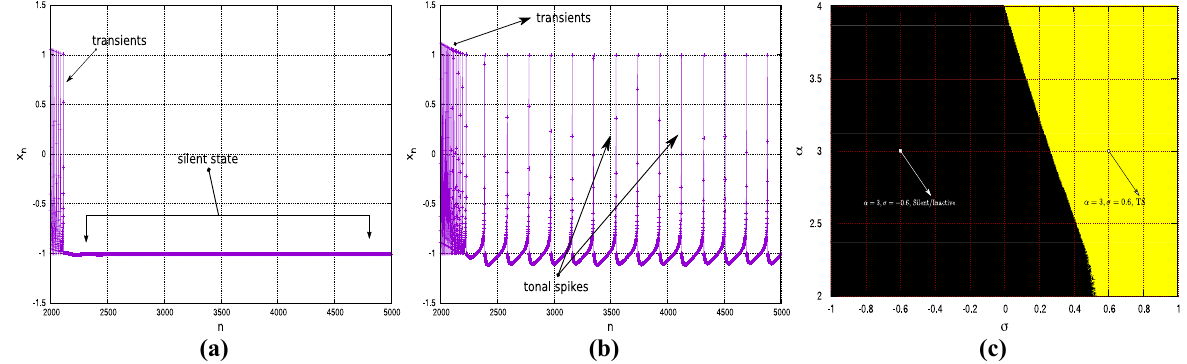
Figure 10. Time-series plots of an isolated neuron exhibiting different dynamical states at long time: ( a ) dead/ silent (DS), ( b ) tonal spiking (TS). ( c ) The dynamical state in the (α , σ) parameter space: black is the DS state; yellow is the TS state. The arrow-marked points in ( c ) correspond to α = 3, σ = ± 0.6 and are the values of these parameters used in the numerical